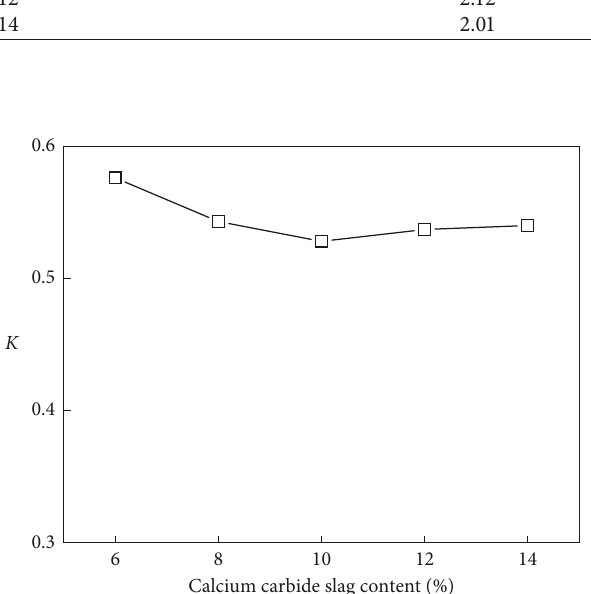
Figure 9: Evolutions of the parameter K with the calcium carbide slag